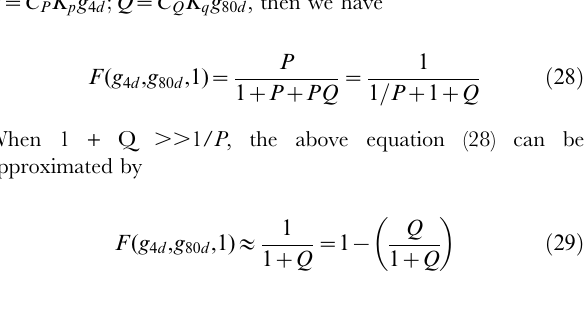
~ 4 | 10 7 molec : Panel (B): Sensitivities when e is higher, the parameters are more sensitive, besides a 1 e